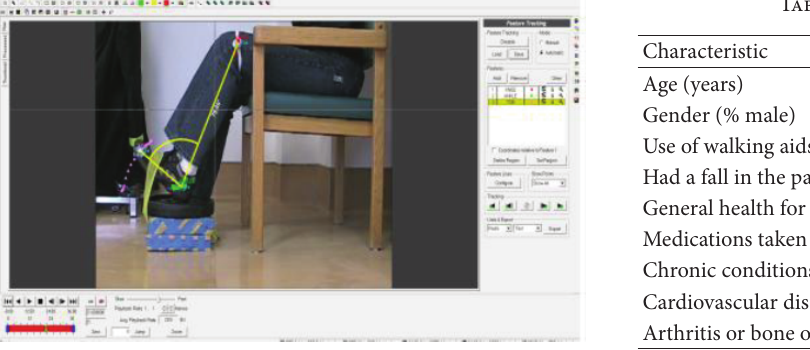
Figure 1: A sample is shown of one of the investigators performing a dorsiflexion contraction, within the software used to analyze the repetitions.